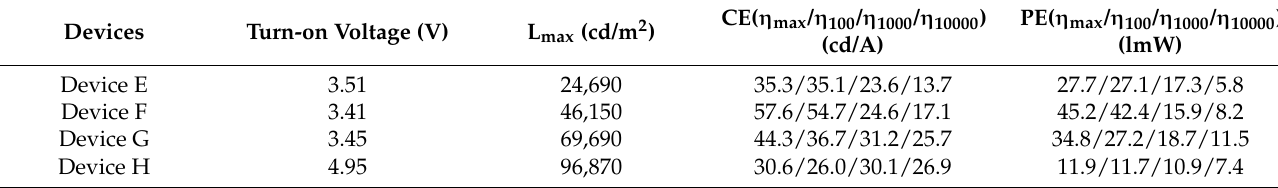
Table 1. The performances of devices E – F.